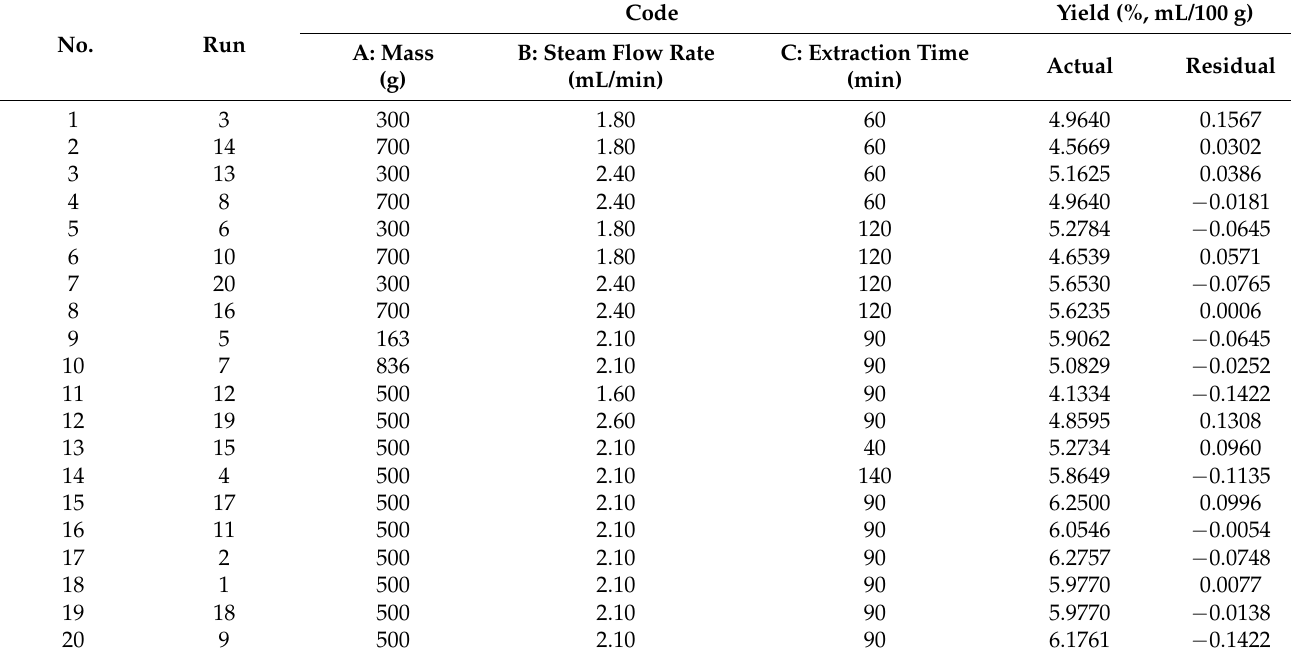
Table 3. Matrix of experimental and predicted values of 20 RSM